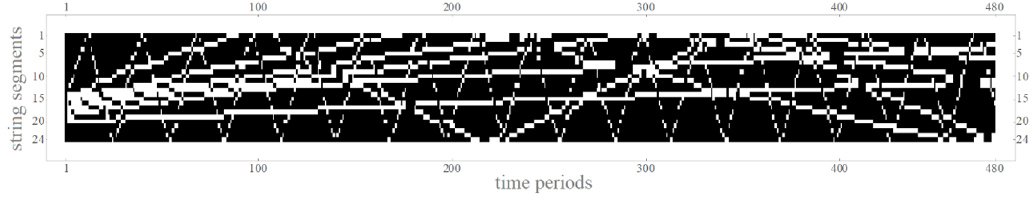
Figure 18 . Recurrence plot of cusps on the worldsheet. The parameters of the simulation are ∆ t = 8 , (cid:15) = 0 . 1 , N = 50 . Each pixel column in the plot is separated by the oscillation period kink (i.e. 2 N discrete time steps) under which the sinh-Gordon interval (shown in white) bounces off kink both string endpoints and moves back to the same position. The interval quickly disintegrates after a few periods.